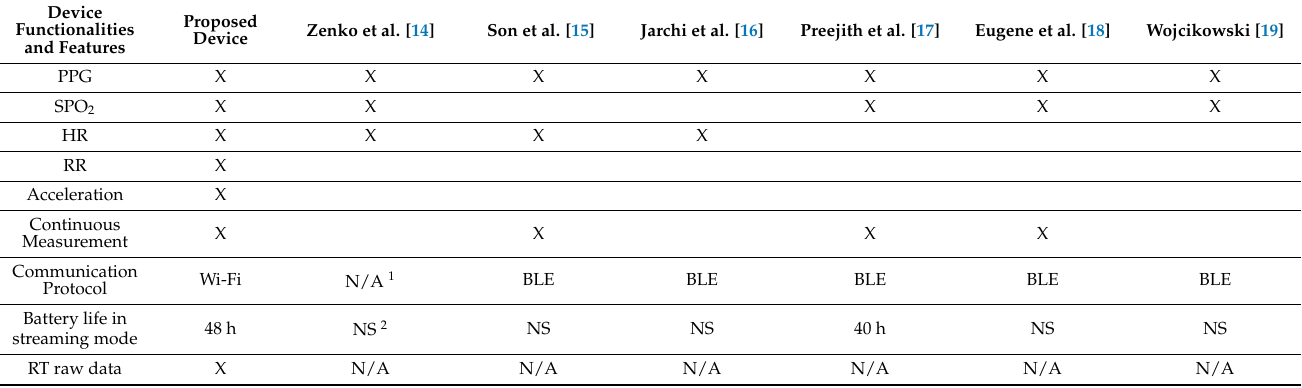
Table 1. Indicative functionalities and features of prototypes emerged from literature research.